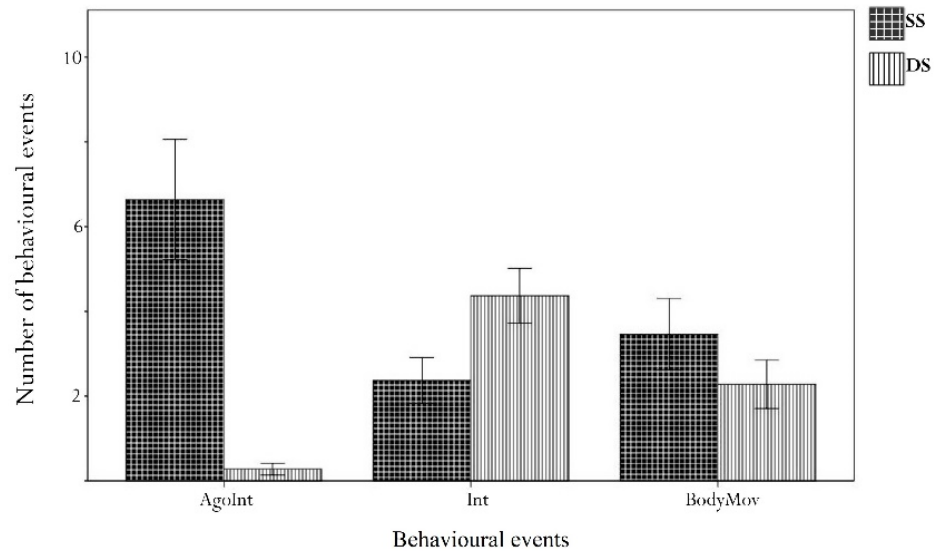
Figure 3. Comparison of average number ( ± SE) of behavioural events: Agonistic Interaction (AgoInt), non-agonistic Interaction (Int), and Body Movements (BodyMov) during SS and DS experimental settings.